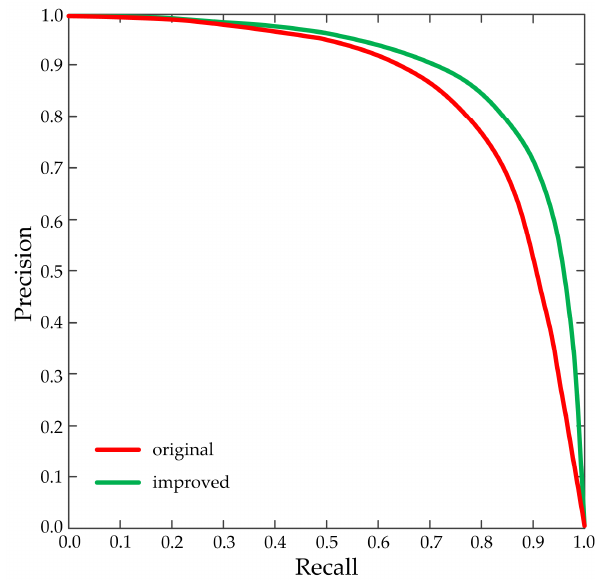
Figure 7. The precision-recall curves about the original and improved SSD.